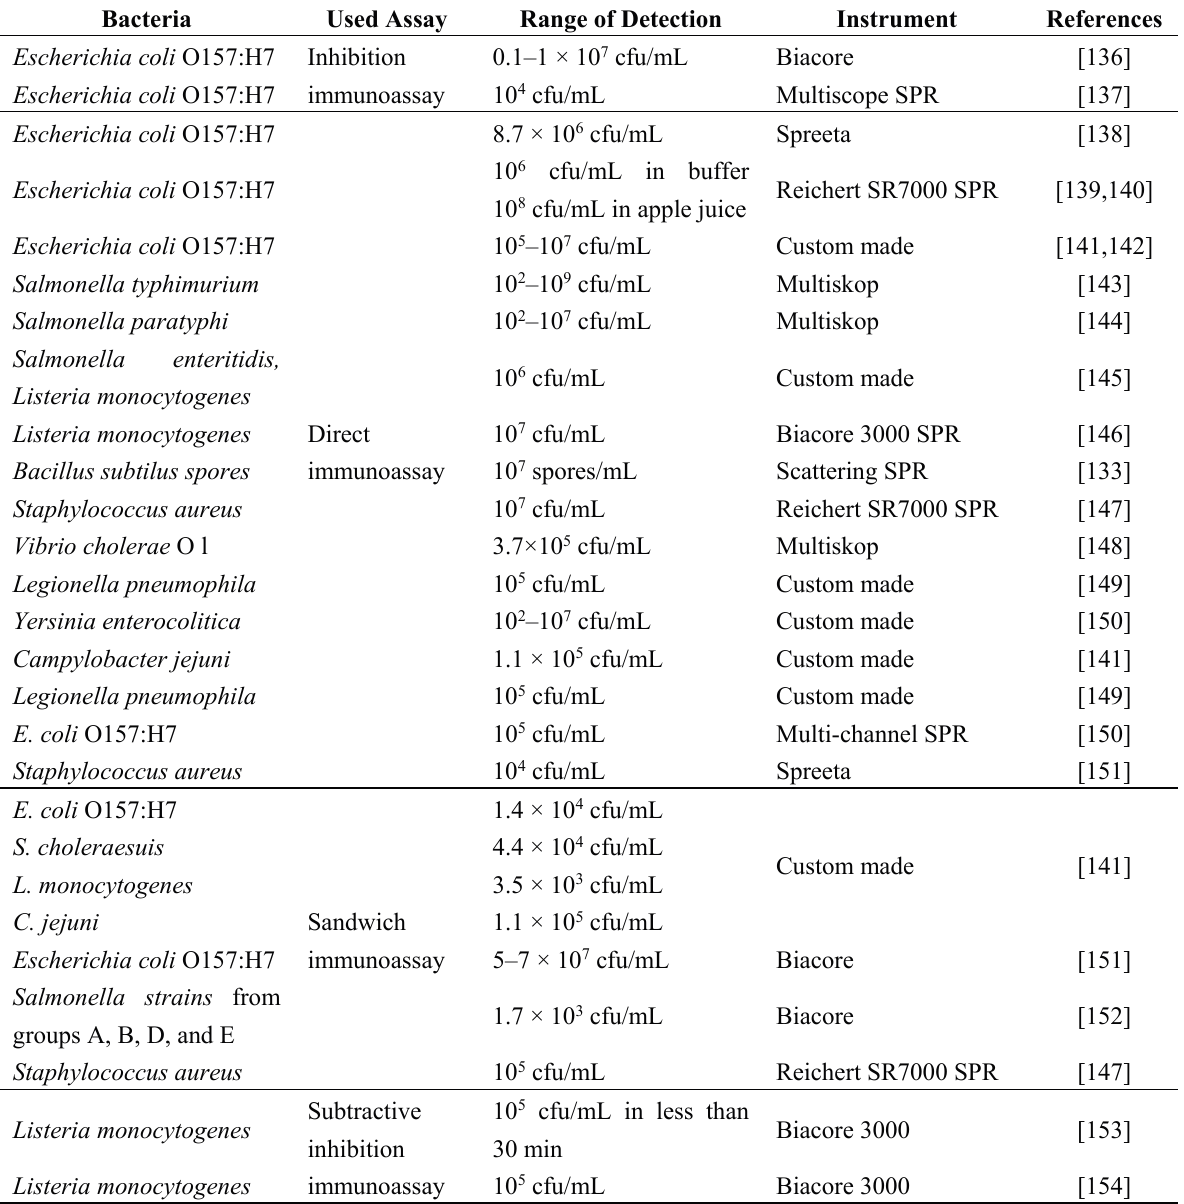
Table 5. Detection of bacteria with SPR biosensors.